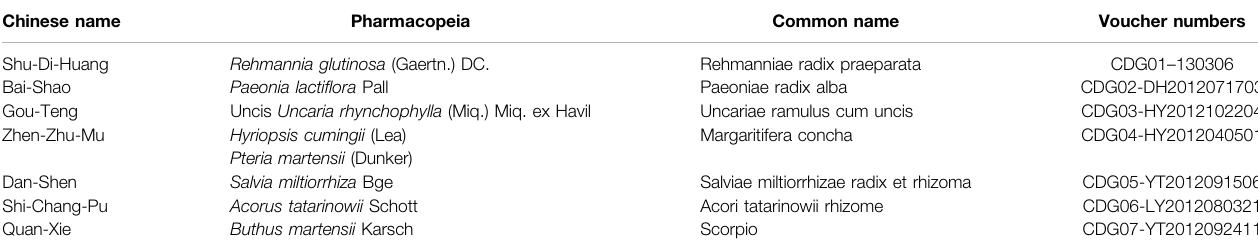
TABLE 1 | Components of Compound Dihuang Granule (CDG).